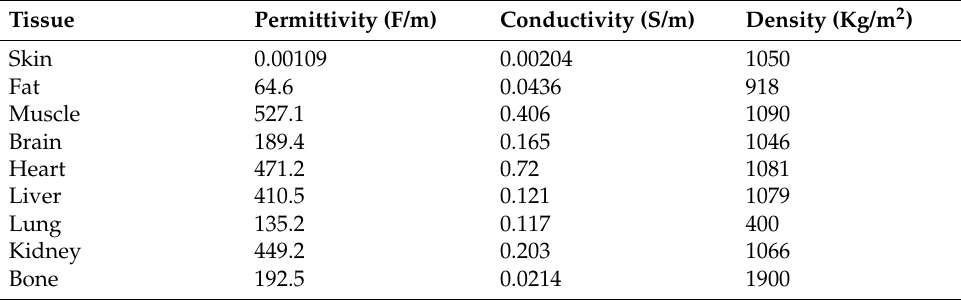
Table 4. Tissue sensitivity values at 0.35 MHz.